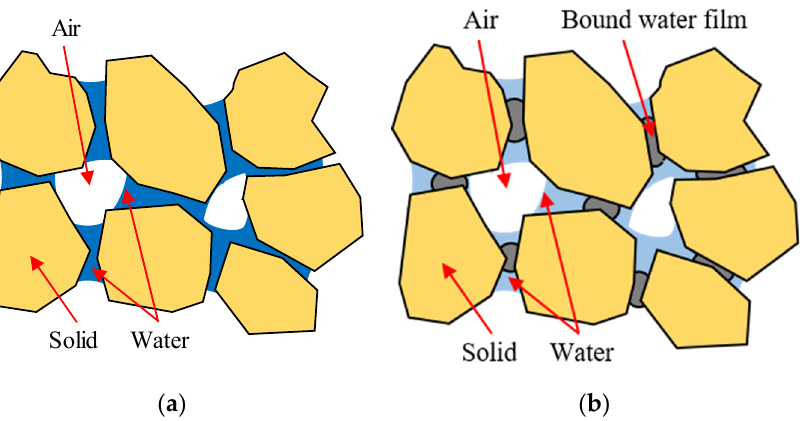
Figure 3. Schematic diagram of mediums in unsaturated soil: ( a ) solid liquid gas three phase system; ( b ) four phase diagram.